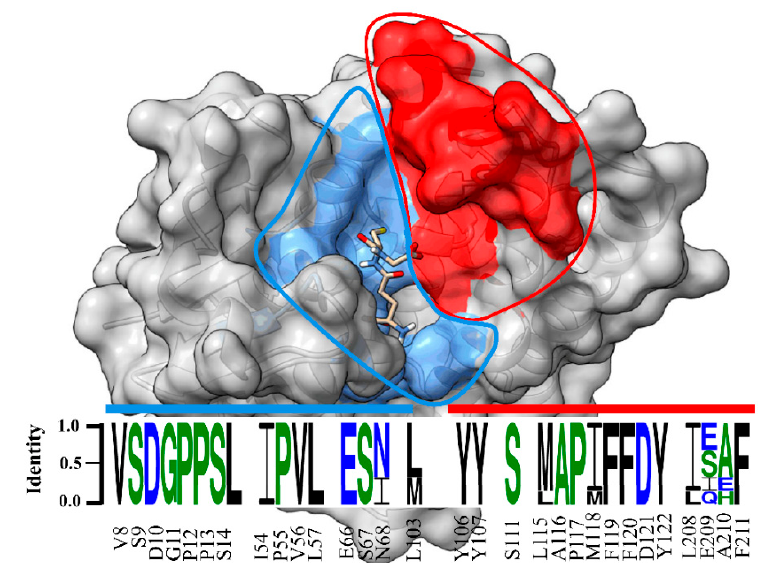
Figure 9. Sequence logo of amino acids in the substrate binding pocket of unclassified insect GSTs. Sequence identity is represented by the letter size. Amino acid number and type label on x-axis is representative of the LdGSTu1 sequence. The sequence logo is overlayed on a surface representation of LdGSTu1. The G-site is colored in cornflower blue and the H-site is colored in red. Residues in the sequence logo are separated by signature motifs identified in the substrate binding pocket region of LdGSTu1 upon multiple alignment with other unclassified insect GSTs. Sequences used for the multiple sequence alignment are the unclassified GST sequences from phylogenic analysis (Table S3). Sequence logo was generated with WebLogo 3 (http://weblogo.threeplusone.com/manual.html, accessed on 2 November 2021).